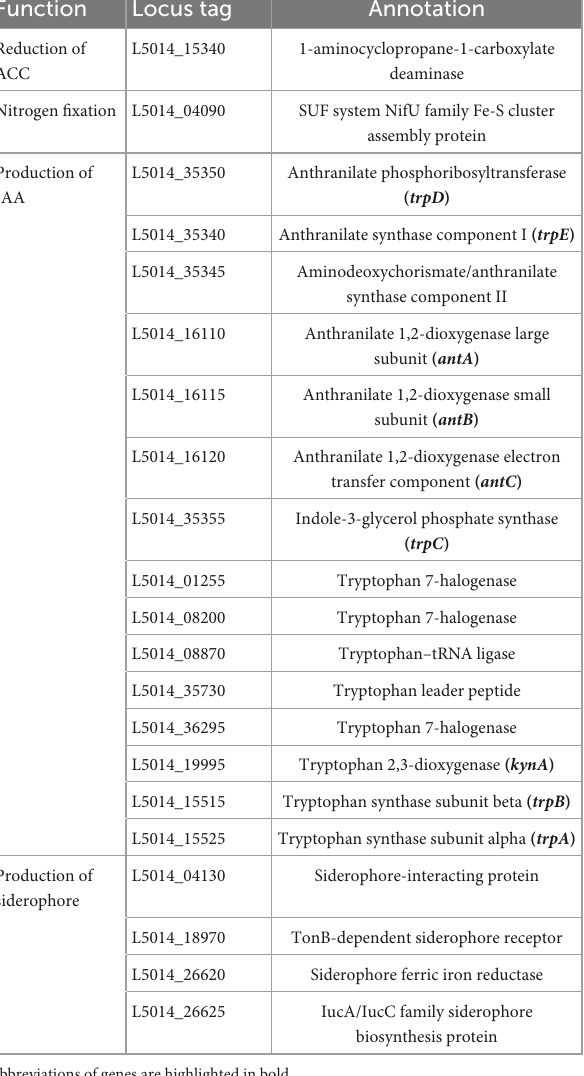
TABLE 3 Putative genes associated with pyrroloquinoline-quinone synthase in the genome of strain RG36 T . Function Locus tag